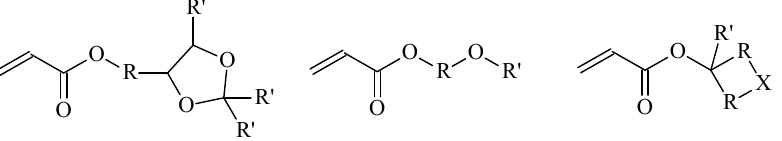
Figure A1. Structure of acrylate monomers described in [199].